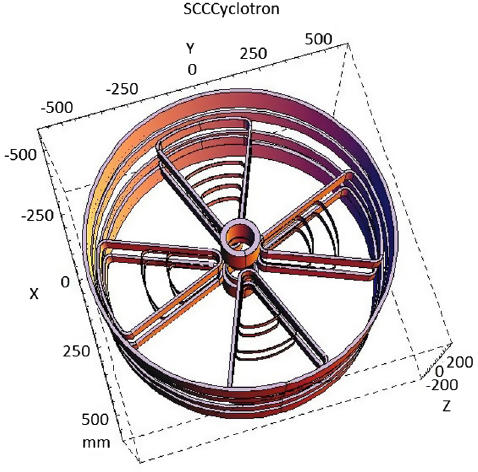
FIG. 1. RADIA Model of the superconducting circular coils, sector coils, and trim coils.